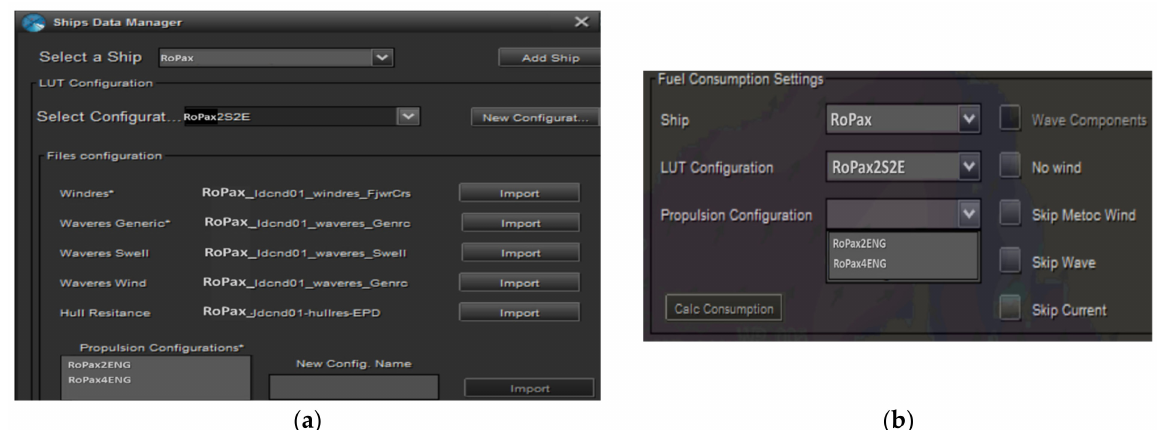
Figure 6. Dialog windows of the prototype system: ( a ) Settings for loading ship specific data from input LUTs files and defining different configurations for the same ship; ( b ) Selection of the ship configuration prior to activating each fuel consumption computation. The case study RoPax ship settings are